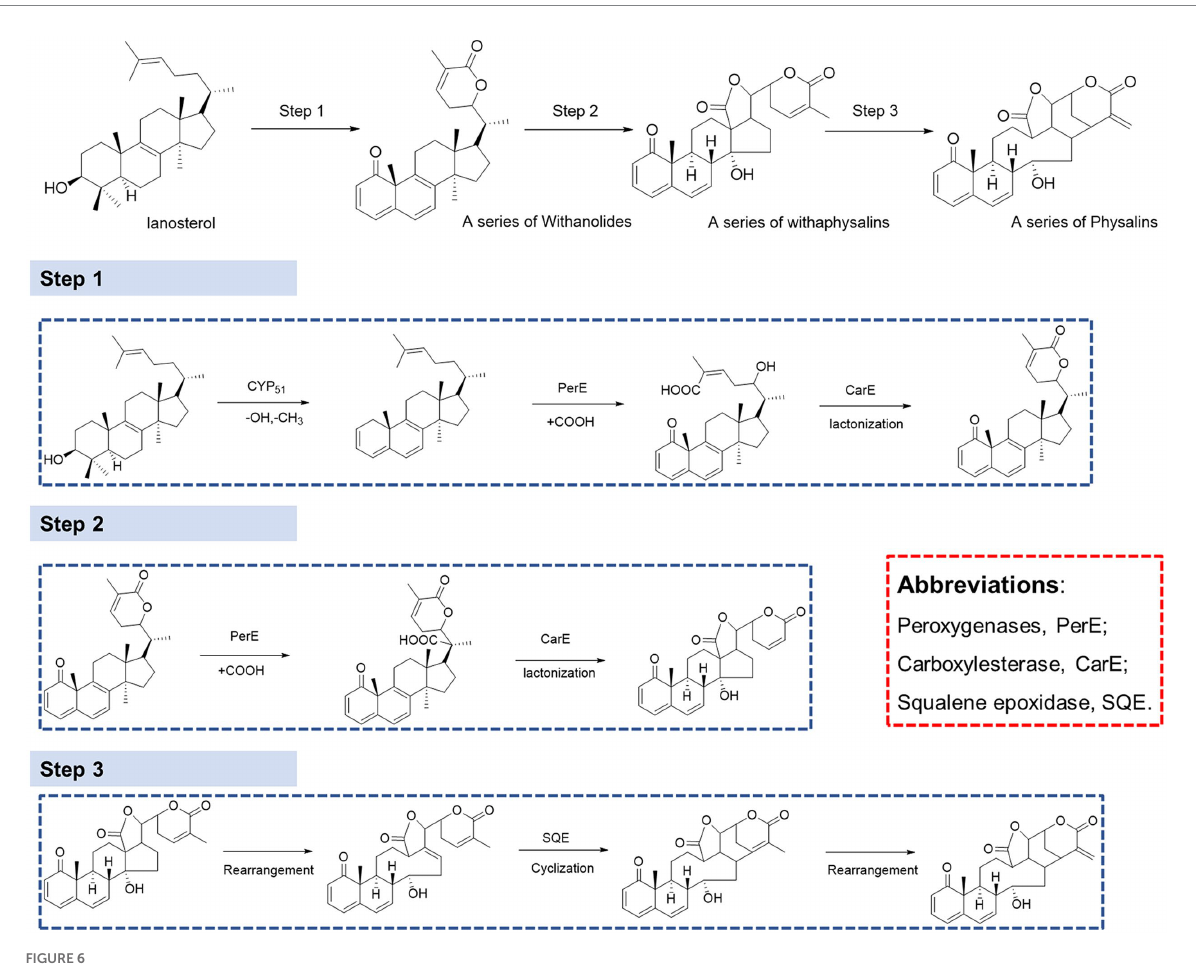
FIGURE 6 Heatmaps of physalin metabolites in berry and calyx. Physalins are more abundant in calyxes, and withanolides and withaphysalins are more abundant in berries, confirming the biosynthesis and structural modifications in fruit